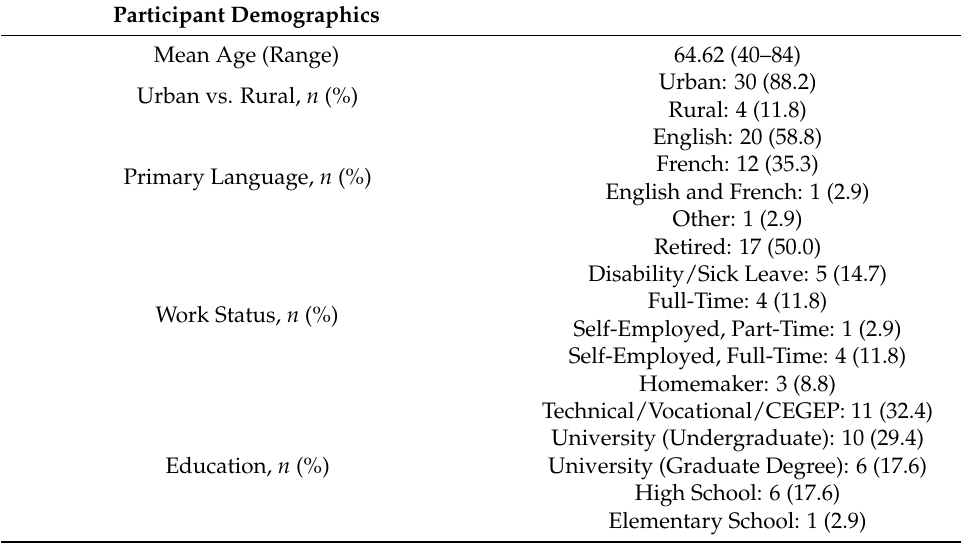
Table 1. Participant demographics. CEGEP: coll è ge d’enseignement g é n é ral et professionnel (general and vocational college). Education demographics denote highest level of education